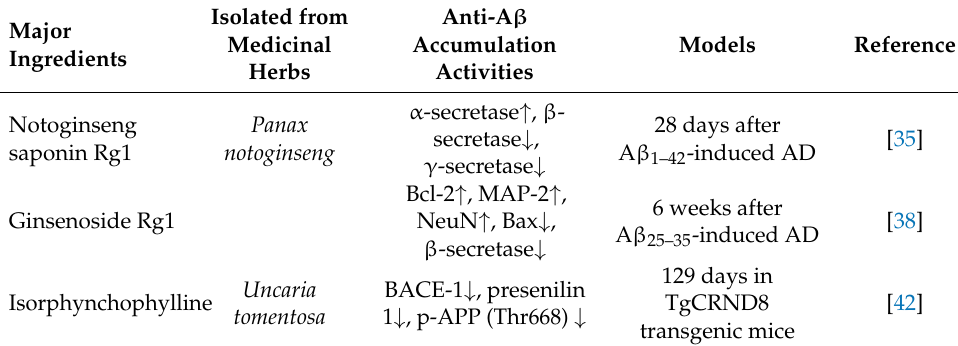
Table 1. MHDIs that suppress A β accumulation in AD animal models.